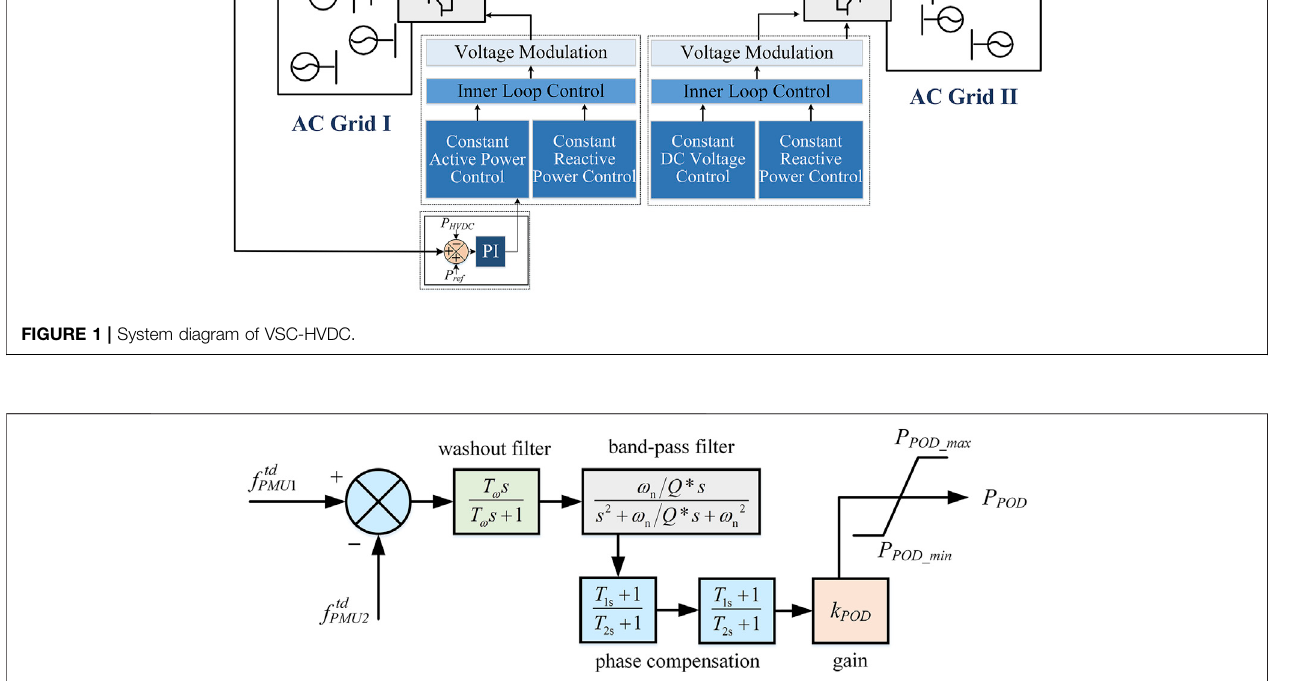
FIGURE 2 | Control diagram of